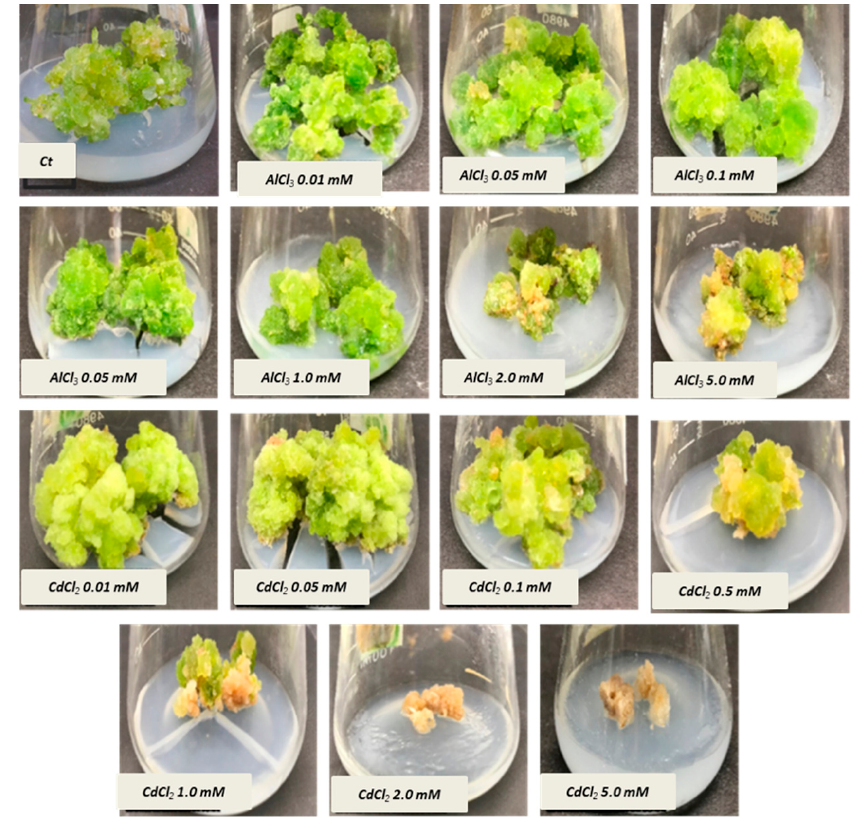
Figure 1. Morphological characteristics of calli incubated for 35 days under different concentrations of aluminum chloride (AlCl 3 ) and cadmium chloride CdCl 2 (color, texture, and